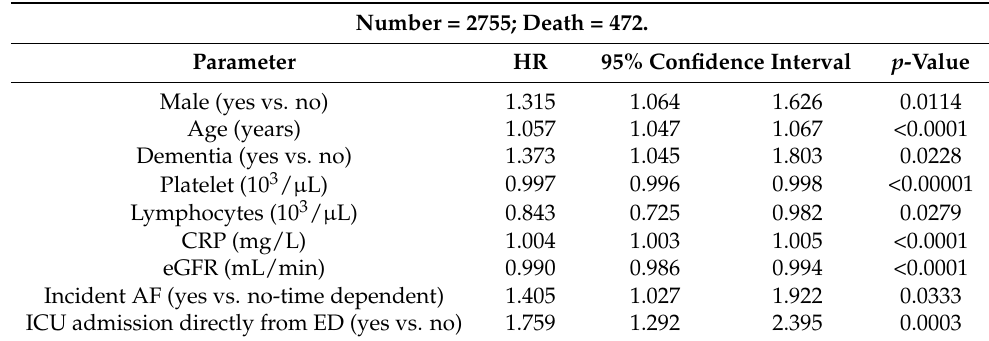
Table 3. Cox multivariable regression model on death with stepwise backward variable selection (variables with p < 0.05 were retained; age and sex were forced in the model). Number = 2755; Death =